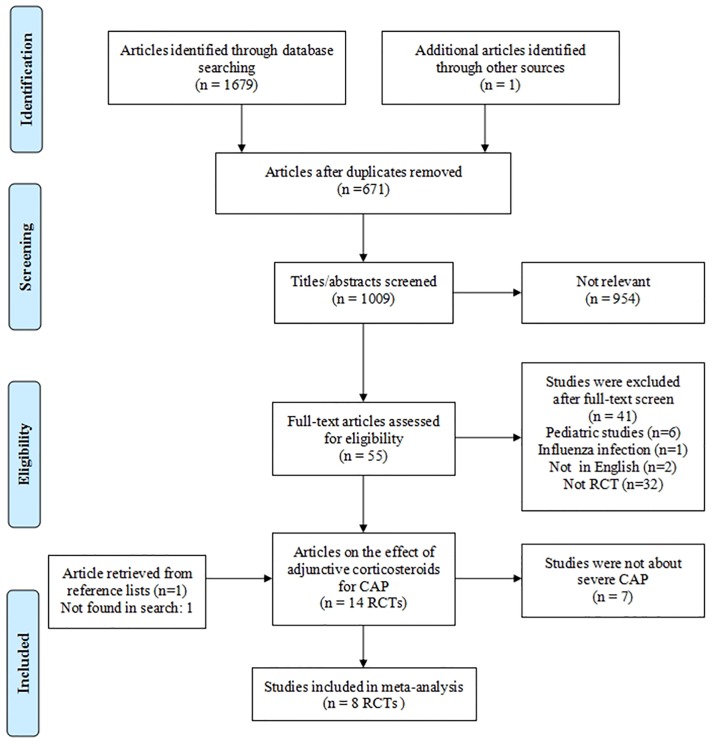
Flow diagram of the study selection process.